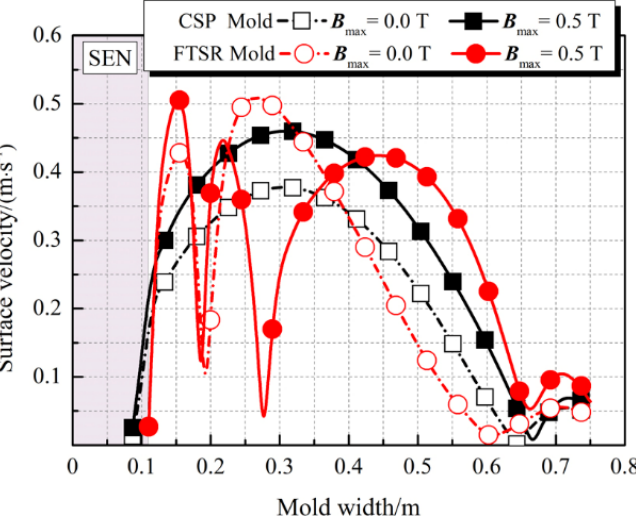
Figure 15. Effect of magnetic flux density on molten steel surface velocity in the two casters.